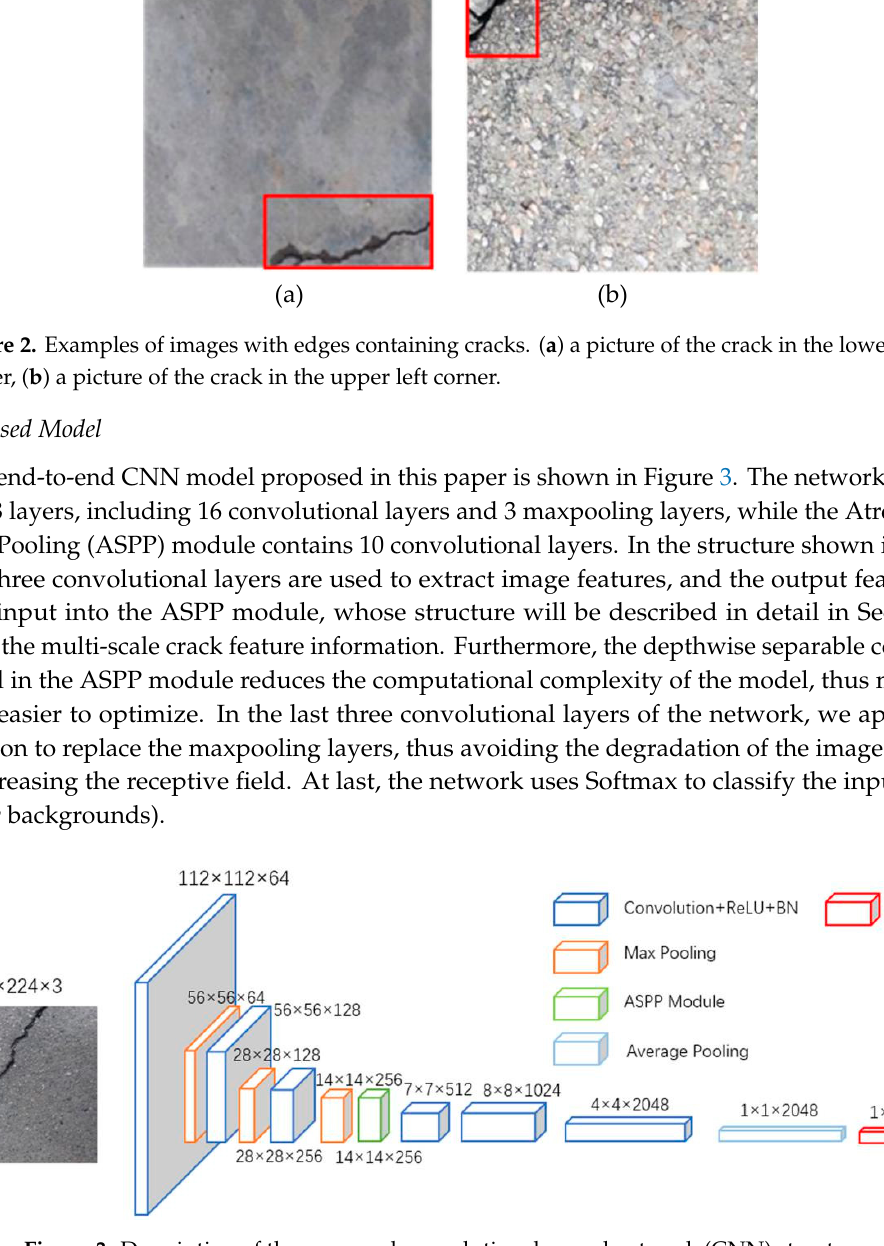
Figure 3. Description of the proposed convolutional neural network (CNN) structure.